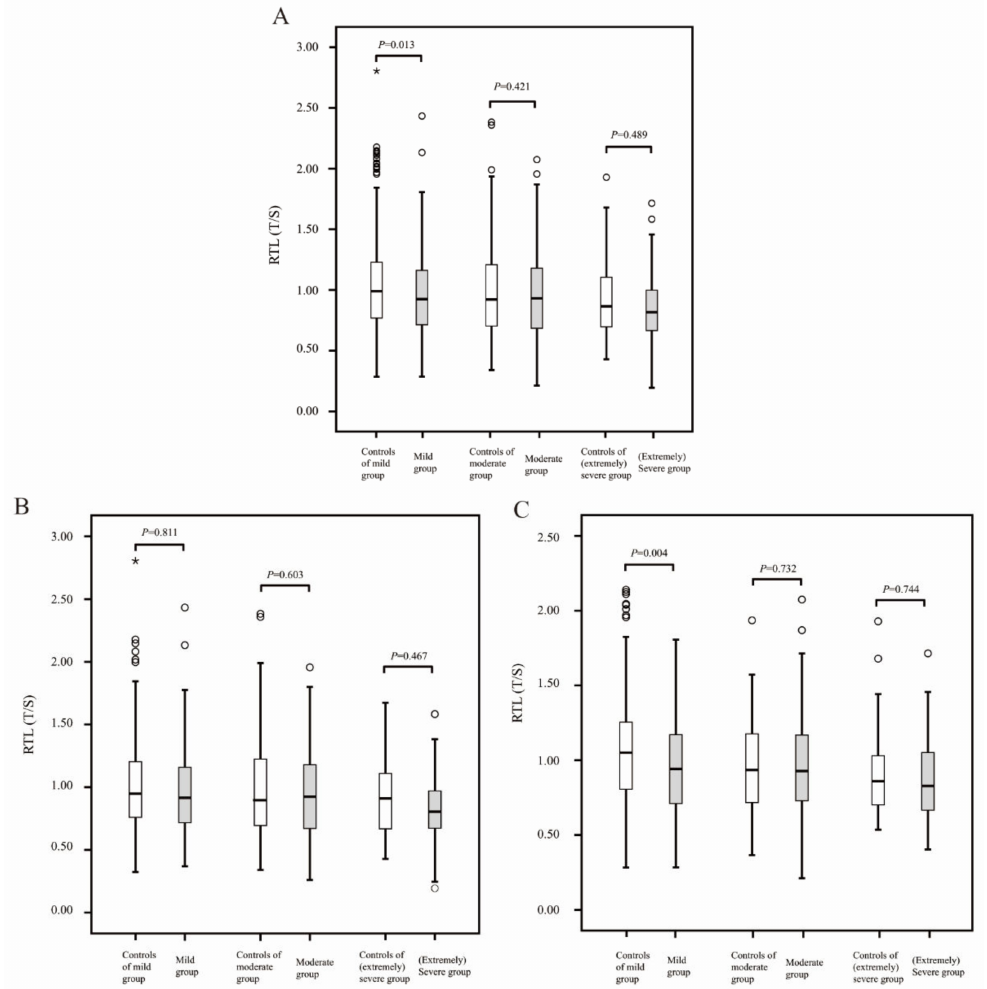
Figure 1. Box plot diagram of relative telomere length (RTL) in di ff erent populations (( A ): total participants; ( B ): male participants and ( C ): female participants). Box plot explanation: upper horizontal line of box, 75th percentile; lower horizontal line of box, 25th percentile; horizontal bar within box, median; upper horizontal bar outside box, maximum value except for outliers; lower horizontal bar outside box, minimum value except for outliers; the hollow circles asterisks represent outliers; p < 0.05 indicates statistical significance between